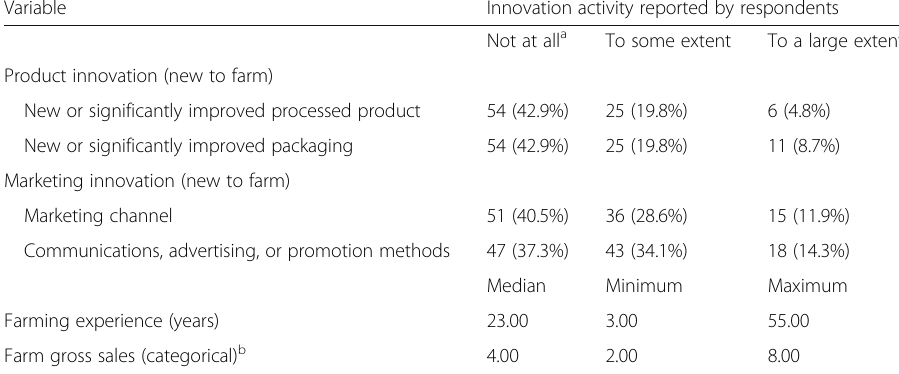
Table 5 Descriptive statistics of innovation variables and control variables Variable Innovation activity reported by respondents Not at all a To some extent To a large extent Product innovation (new to